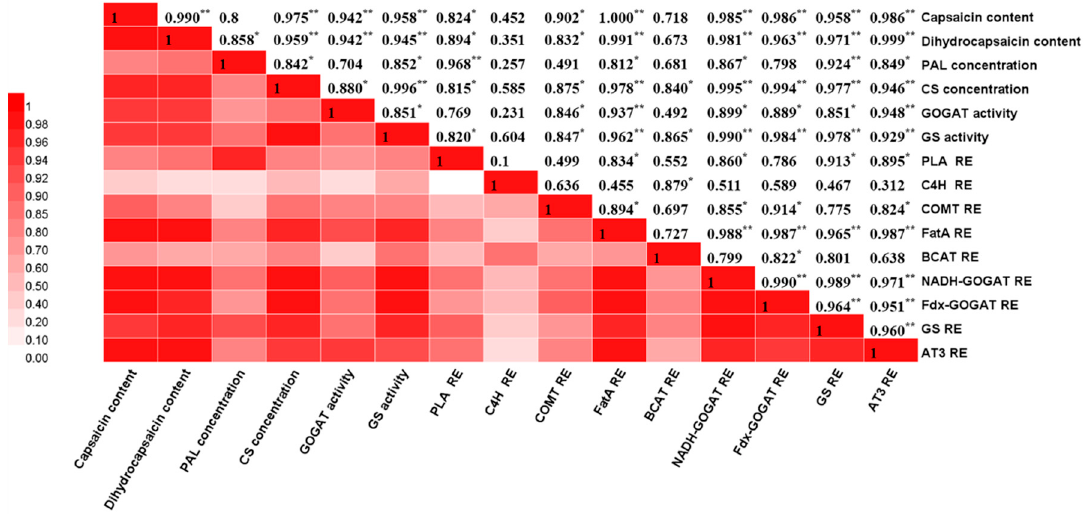
Figure 8. Heat map of Pearson’s correlation coefficients. PAL, phenylalanine ammonia-lyase; C4H, cinnamate 4-hydroxylase; COMT, caffeic acid-3-O-methyltransferase; BCAT, branched-chain amino acid aminotransferase; FatA, acyl-ACP thioesterase; GS, glutamine synthetase; NADH-GOGAT, putative NADH-dependent glutamate synthase; Fdx-GOGAT, putative ferredoxin-dependent glutamate synthase; AT3, acyltransferase; RE, relative expression. Values are Pearson’s correlation coefficients. * and ** denote correlation coefficients that are significant at p < 0.05 and 0.01 level, respectively.